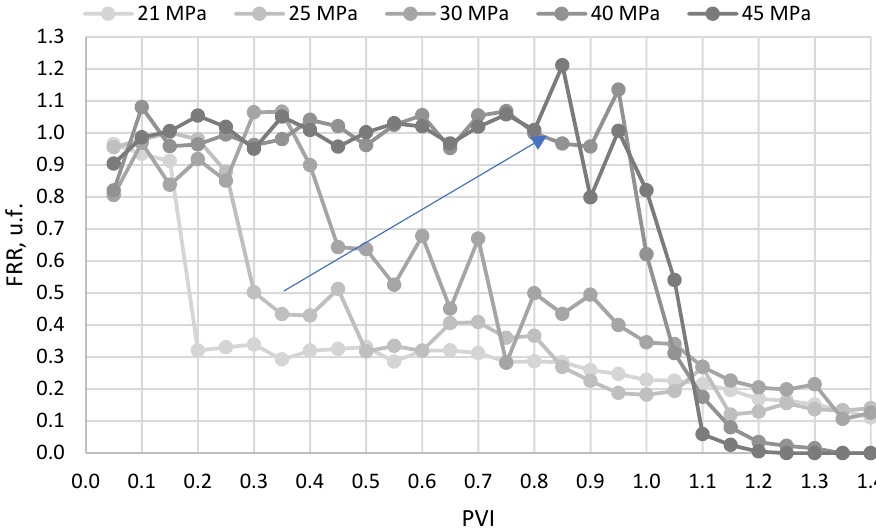
Figure 7. FRR value dynamics for APG injection at pressures 21–45 MPa. In the case of a miscible displacement, on the contrary, the FRR reaches a plateau of stable values near 1 and does not change until the gas breakthrough at 0.9–0.95 PVI. On the FRR profile, with an increase in the pressure stage, the shape of the curve tends to the characteristic shape of the curves corresponding to the miscible displacement, as shown by the arrow. It can be assumed that the injection pressure at which the FRR curves have a characteristic profile and at average FRR values equal to 1, the miscibility will be reached. Based on this, the average FRR values on the immiscible displacement pressure steps 21–30 MPa were extrapolated to find an intersection with the FRR value of 1, which refers to a miscible displacement (Figure 8).